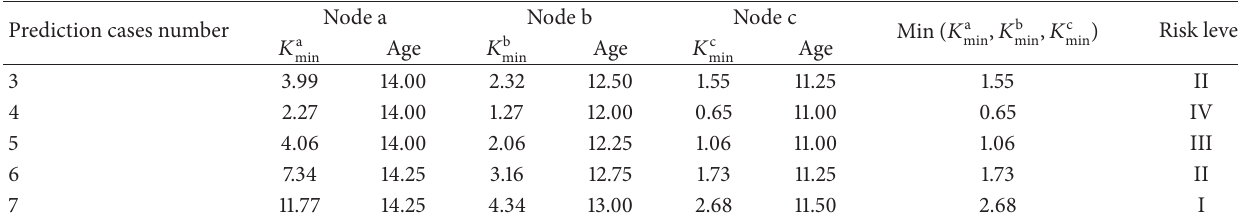
Table 6: Crack risk evaluation level of